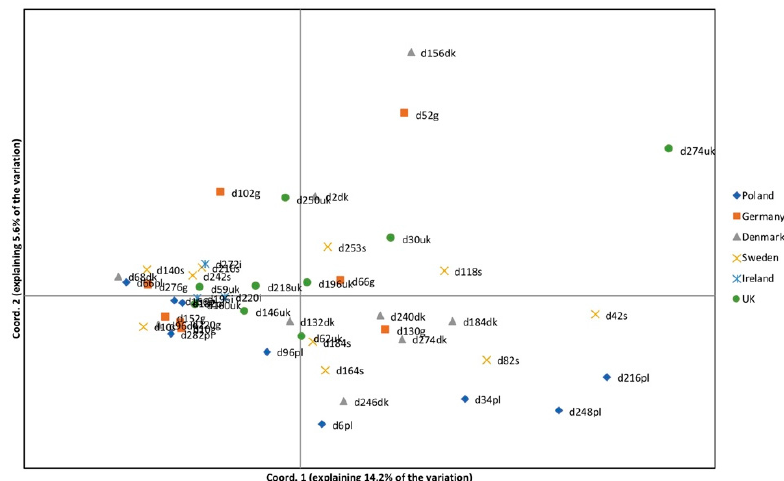
Figure 4. PCA of the plastome data. Axis one accounts for 14.2% of the variation and axis two for 5.6% of the variation. Some weak pattern can be seen relating to the geographical origin of samples. For example, samples from Ireland and UK are more common in the central region of the plot and Polish samples are only found in the lower region of the plot.